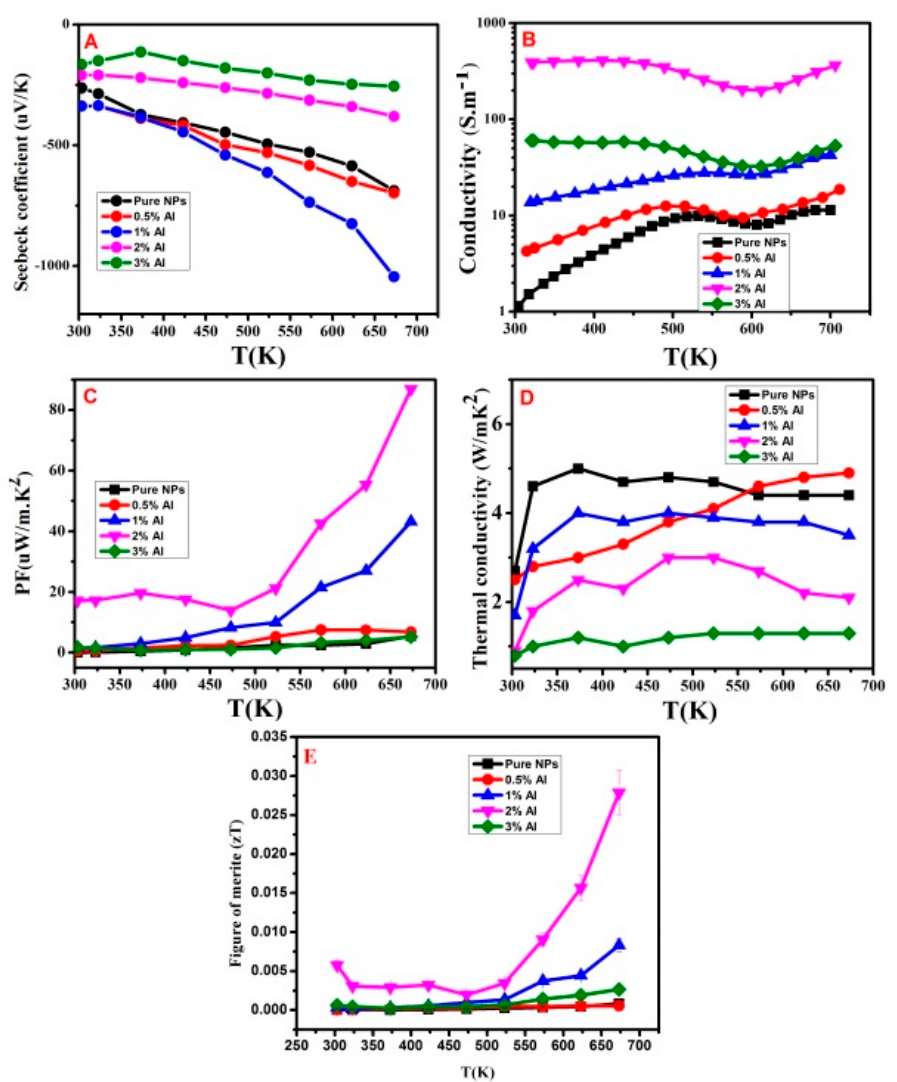
Figure 8. Thermo-electrical properties of pure and Al doped ZnO NSs. ( A ) Seebeck coefficient, ( B ) electrical conductivity, ( C ) power factor measurements, ( D ) thermal conductivity, and ( E ) figure of merit.